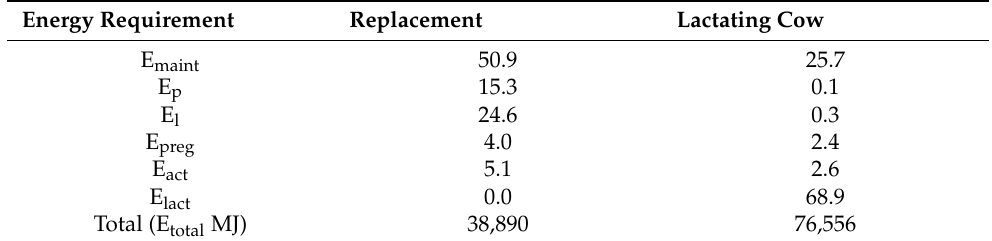
Table 5. Percentage of total metabolizable energy (% of ME) for a heifer replacement and the average lactating dairy cow for maintenance (E maint ), protein (E p ) and lipid growth (E l ), pregnancy (E preg ), activity (E act ) and milk production (E lact ) for the current herd